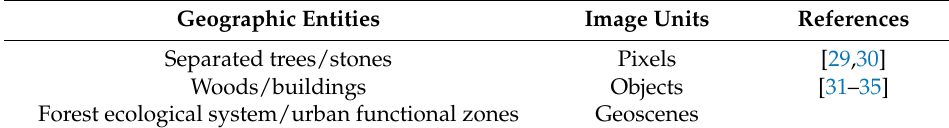
Table 1. Relations between geographic objects and analytical units.